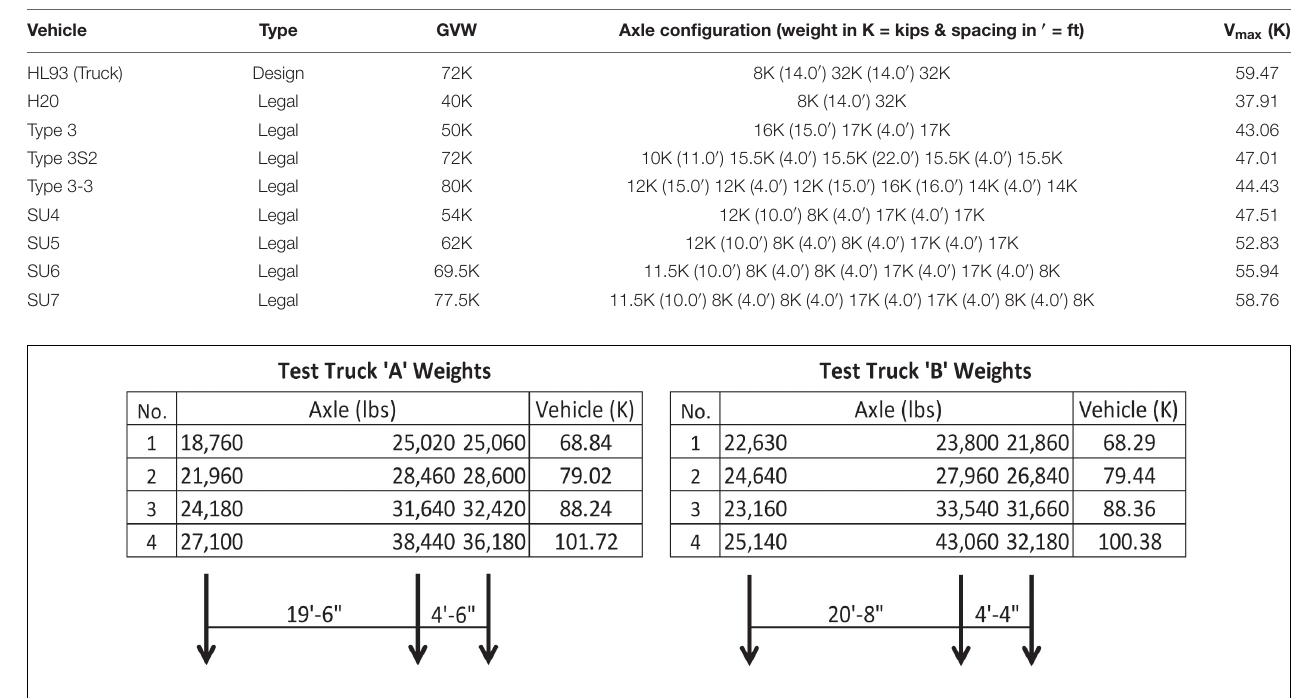
FIGURE 8 | Test trucks axle configurations and weights at four different levels. TABLE 2 | Descriptions of 13 test runs at weight level no. 2 (WL#2). Test run no.